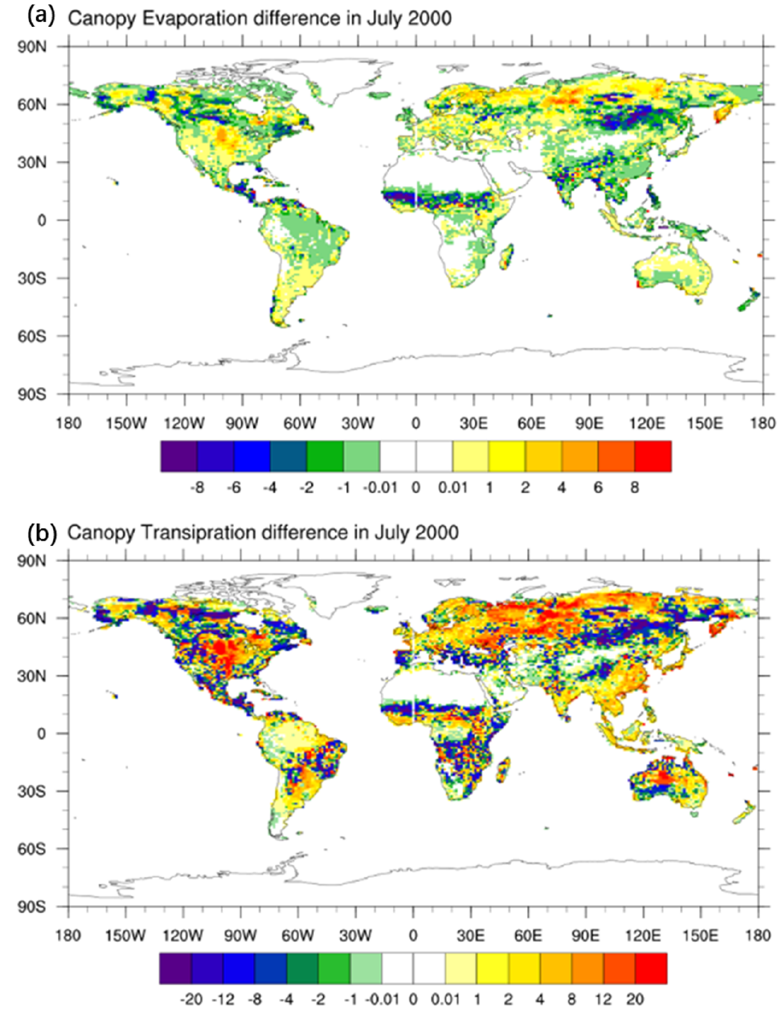
Figure 9. The difference between ESACCI and CLM_LS for ( a ) evaporation (unit: W/m 2 ), and ( b ) transpiration (unit: W/m 2 ) (July 2000).